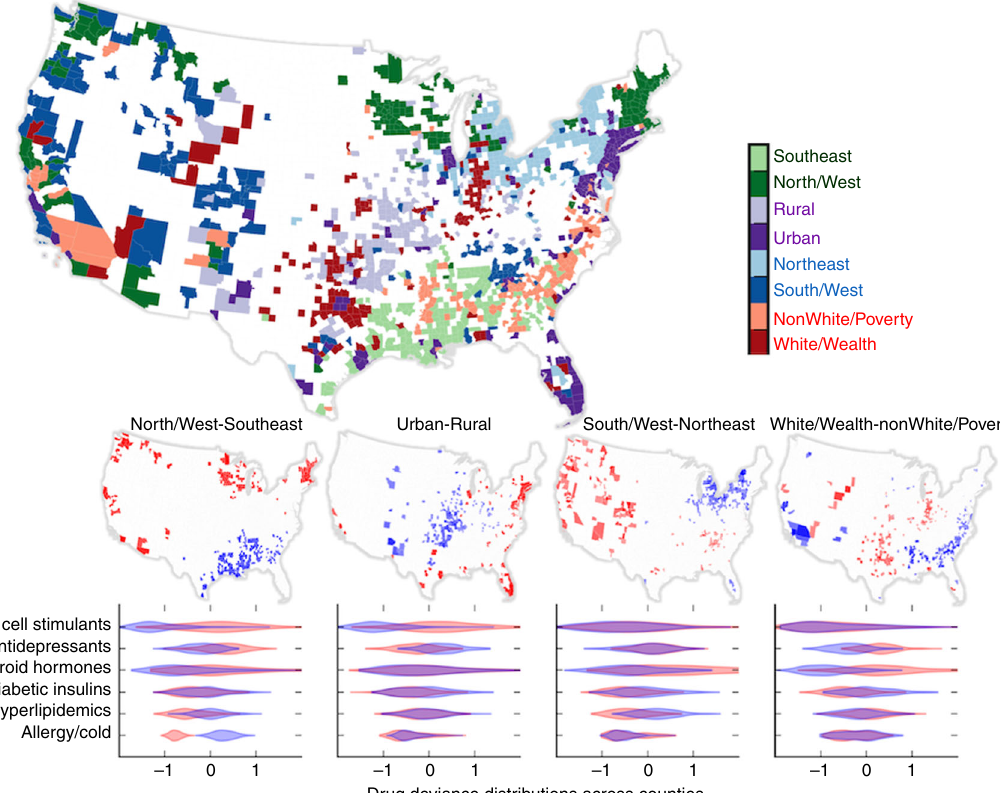
Fig. 4 Summary of the fi rst four components. Each county is assigned to one of the components if it falls into the top or bottom tenth percentile of a component. The map on top shows these assignments, with one hue per component, and lighter color indicating counties with extreme negative projections, darker for extreme positive. The maps in the middle show the same extreme counties, separated into each component. The bottom panel shows the distribution of deviances for some chosen therapeutic drug classes. The overlapping violin plots depict the use of the drugs in the class for counties in the high (red), and low (blue), extremes of each